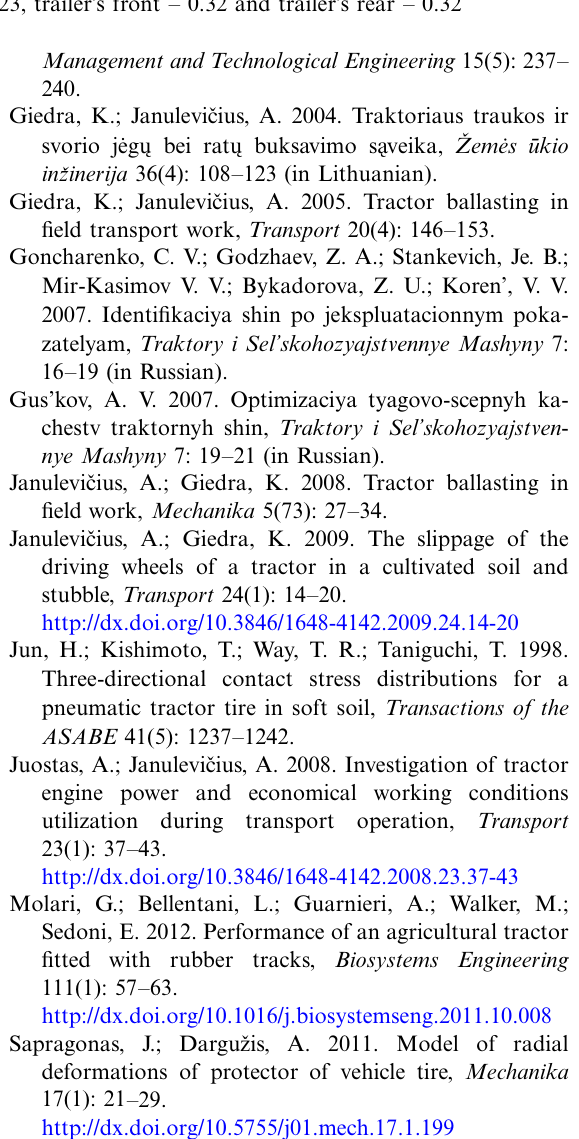
Fig. 10. The dependences of vehicle’s driving wheel’s slippage on the number of activated driving axles and their loads, while driving on a tracks in a plowed field: 1 (cid:2) when total weight of the vehicle is 7100 kg, axle load rates: tractor’s front (cid:2) 0.21, tractor’s rear (cid:2) 0.38, trailer’s front (cid:2) 0.21 and trailer’s rear (cid:2) 0.21; 2 (cid:2) when total weight of the vehicle 11,600 kg; axle load rates: tractor’s front (cid:2) 0.12, tractor’s rear (cid:2) 0.23, trailer’s front (cid:2) 0.32 and trailer’s rear (cid:2)